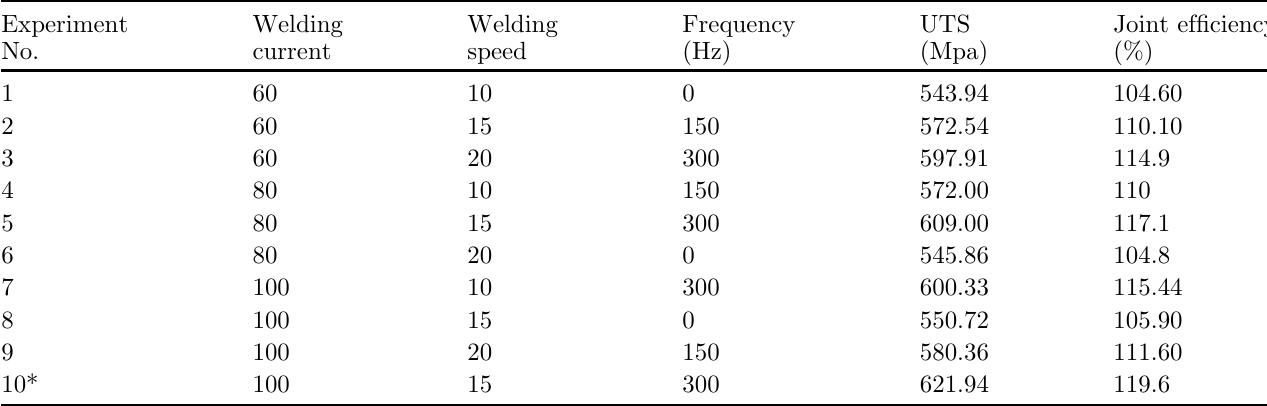
Table 11. Joint ef fi ciency of vibratory welded joints.